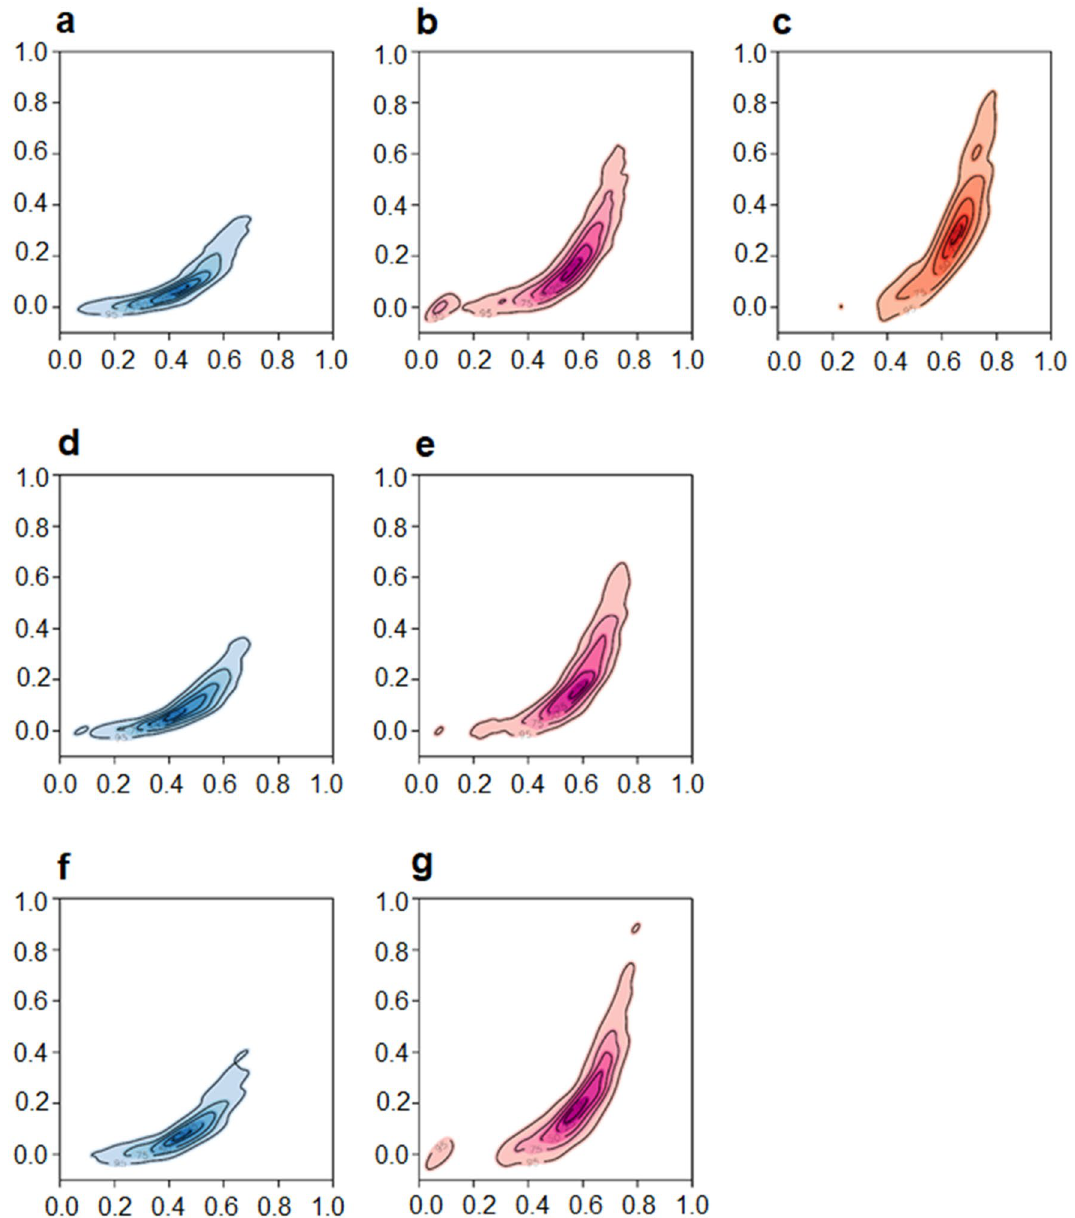
Figure 5. Contour plots of the distributions of clinical covariates optic cup volume (y-axis) and average CDR (x-axis) of the samples belonging to metaclusters of age groups 1: ( a ) M 3 M 3 3: ( f ) M 1 , ( g ) 2 . The metaclusters that correspond across the 3 age groups are shown in matched colors (blue and pink) while the distinct metacluster ( c ) is shown in